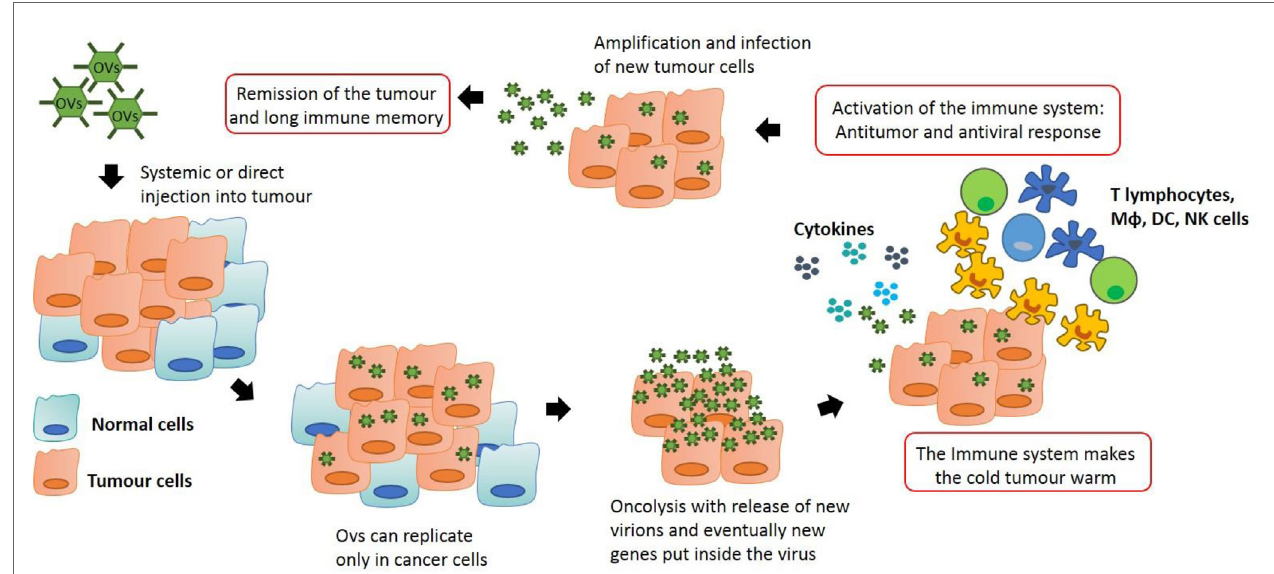
FigURe 1 | Anti-tumor immunity by oncolytic virus (OV) therapy: OVs can be modified in order to let them to replicate only in transformed cells. This process stimulates the immune system which is recruited into the tumor, skewing the neoplastic mass from an immuno-suppressive environment to an inflammatory site. Macrophages and T lymphocytes are key players in this process, producing cytokines that can recruit other immune cells and actively destroy cancer cells. This action generates an immunological memory that avoids cancer recurrence and synergizes with the oncolytic action of the viruses, potentially leading to tumor